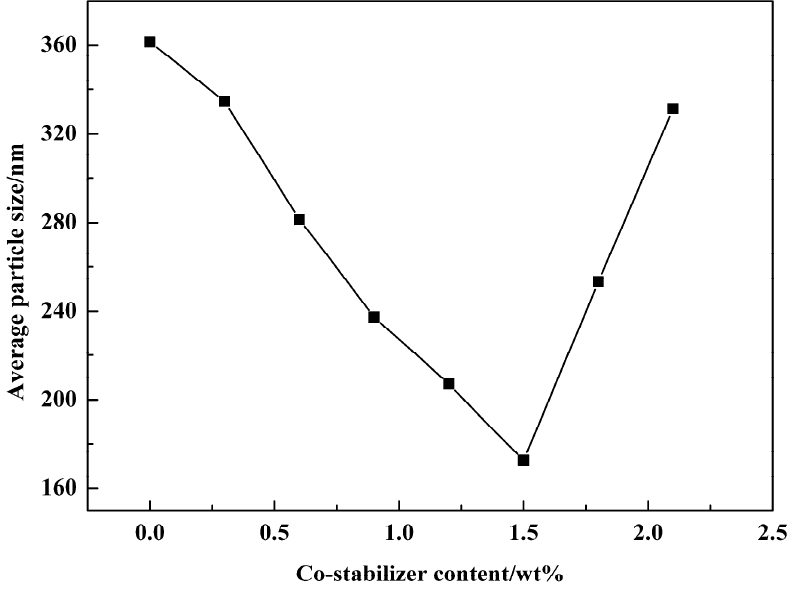
Figure 13. Average particle size of PR 146 obtained from miniemulsions with different co-stabilizer content.